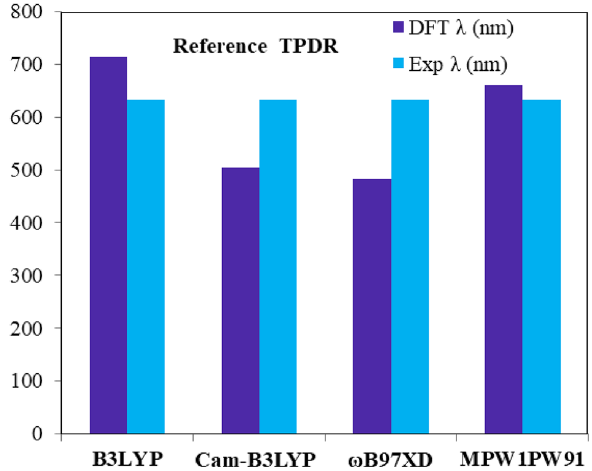
Figure 1. The simulated UV–vis results of TPDR at different DFT